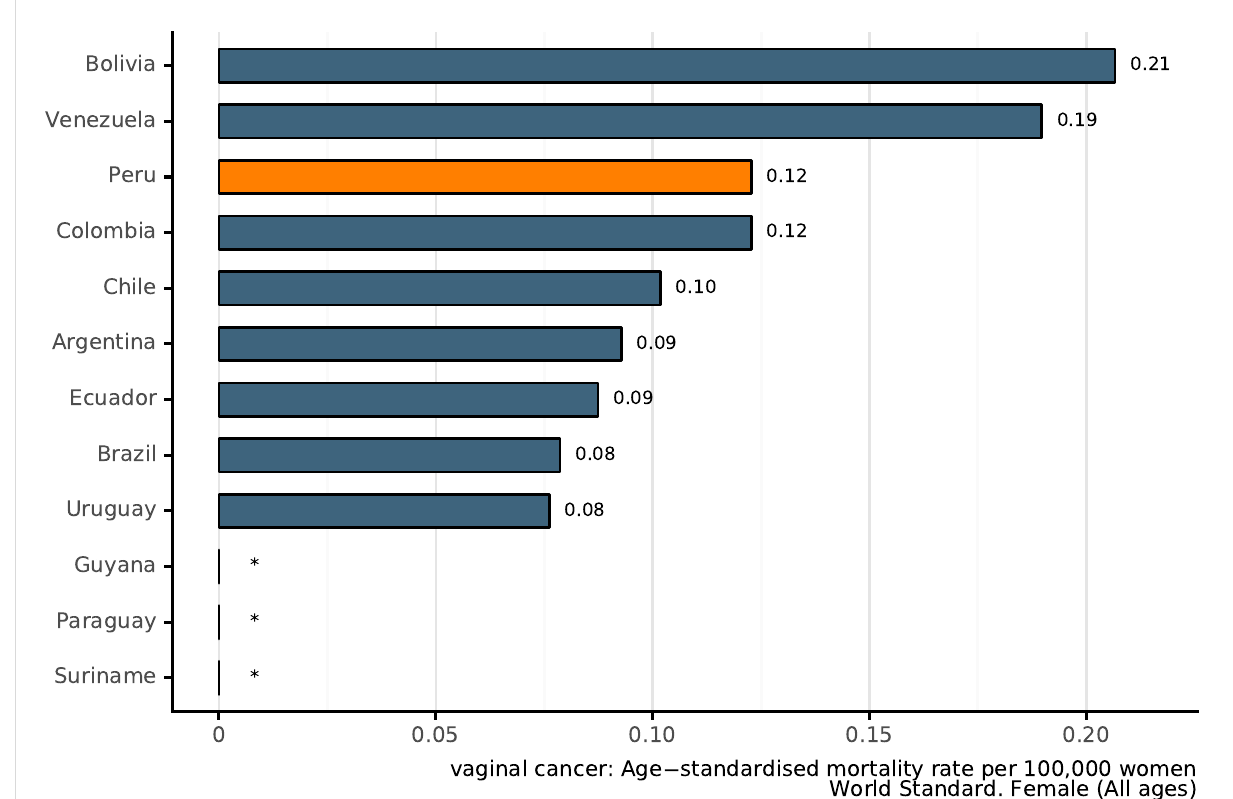
vaginal cancer: Age standardised mortality rate per 100,000 women World Standard. Female (All